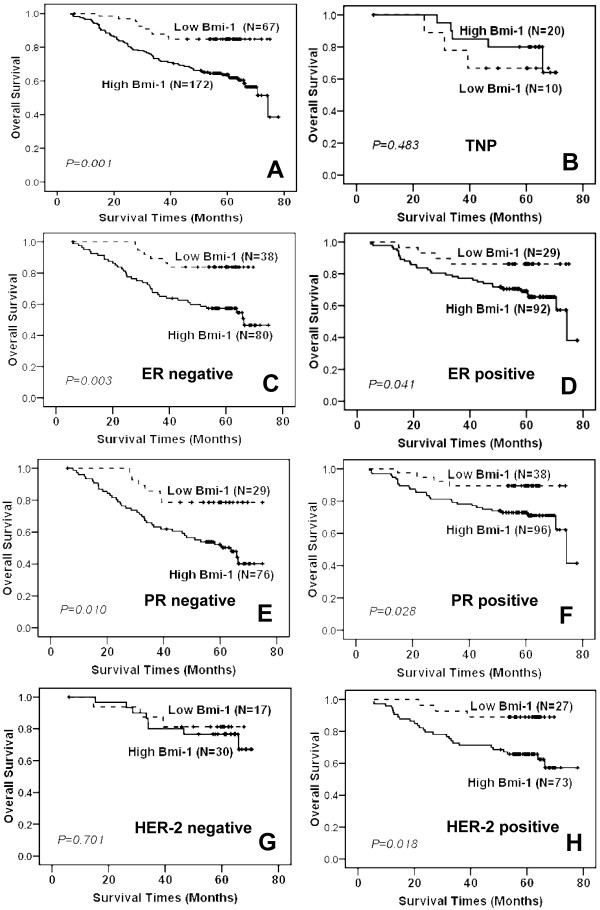
Influence of Bmi-1 expression on the overall survival. (A)The cumulative overall survival exhibited a significant difference based on Bmi-1 expression, assessed by Kaplan-Meier curves in primary breast cancer tissues (***P = 0.001). (B) No difference in the overall survival curve was observed according to Bmi-1 expression in the triple negative phenotype (TNP, ER-, PR-, and HER-2-) subgroup (P = 0.483). (C, D, E, F) High Bmi-1 expression was correlated with unfavorable prognosis irrelevant of the presence of ER (**P = 0.003, *P = 0.041) or PR (**P = 0.010, *P = 0.028). (G, H) The survival curves were significantly different according to Bmi-1 expression in the HER-2 positive panel (*P = 0.018), but not in HER-2 negative panel (P = 0.701).